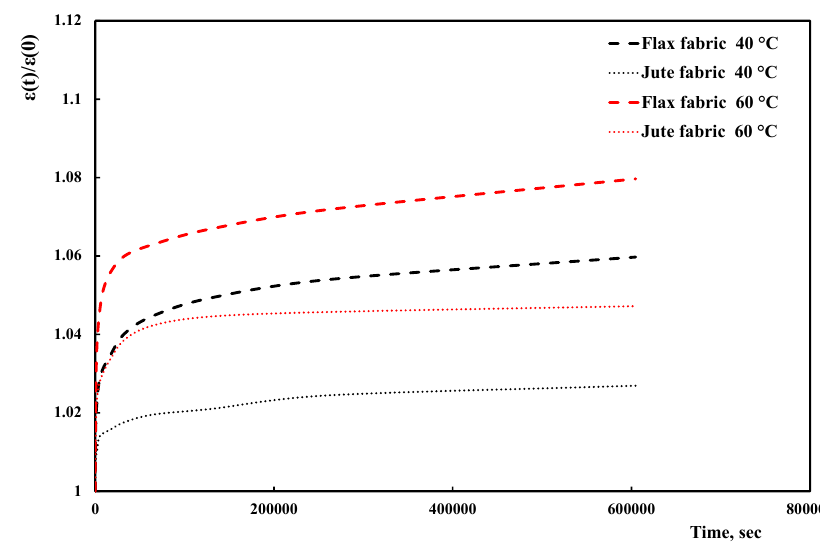
Figure 6. Normalized deformation versus time trends of fabrics at 40 °C and 60 °C.